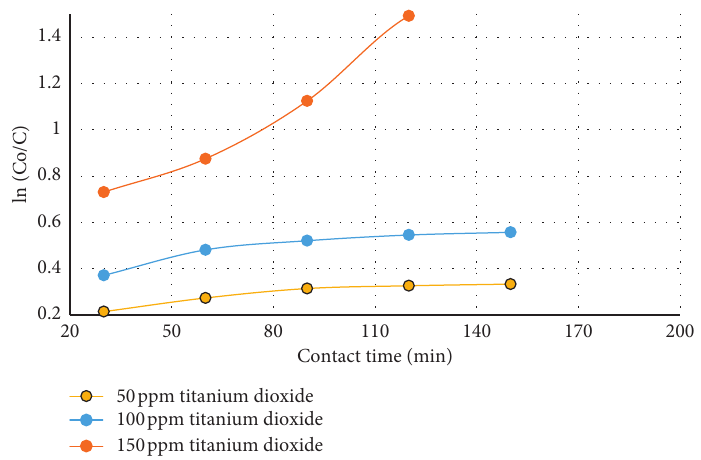
Figure 7: Pseudo-first-order model for degradation of PW using TiO